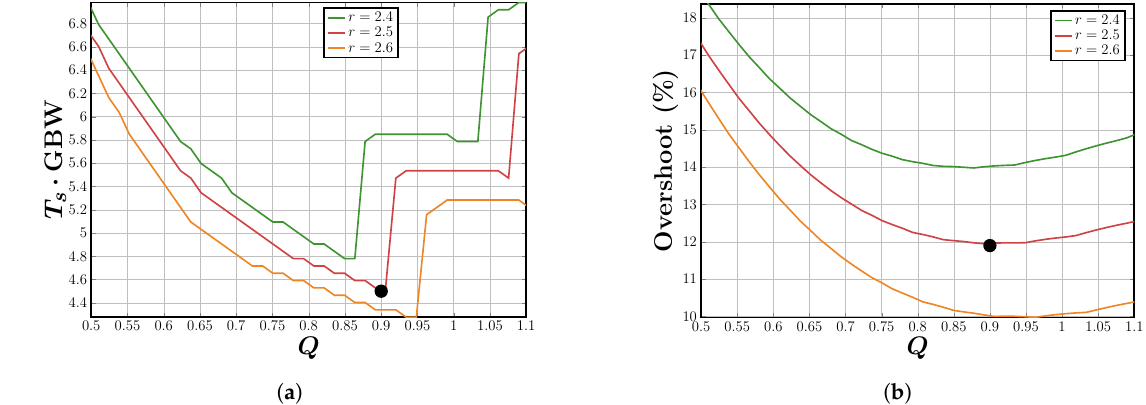
Figure 13. Curves used for the choice of design parameters for the NMC architecture: ( a ) normalized settling time and ( b ) overshoot. The black dot marks the selected design